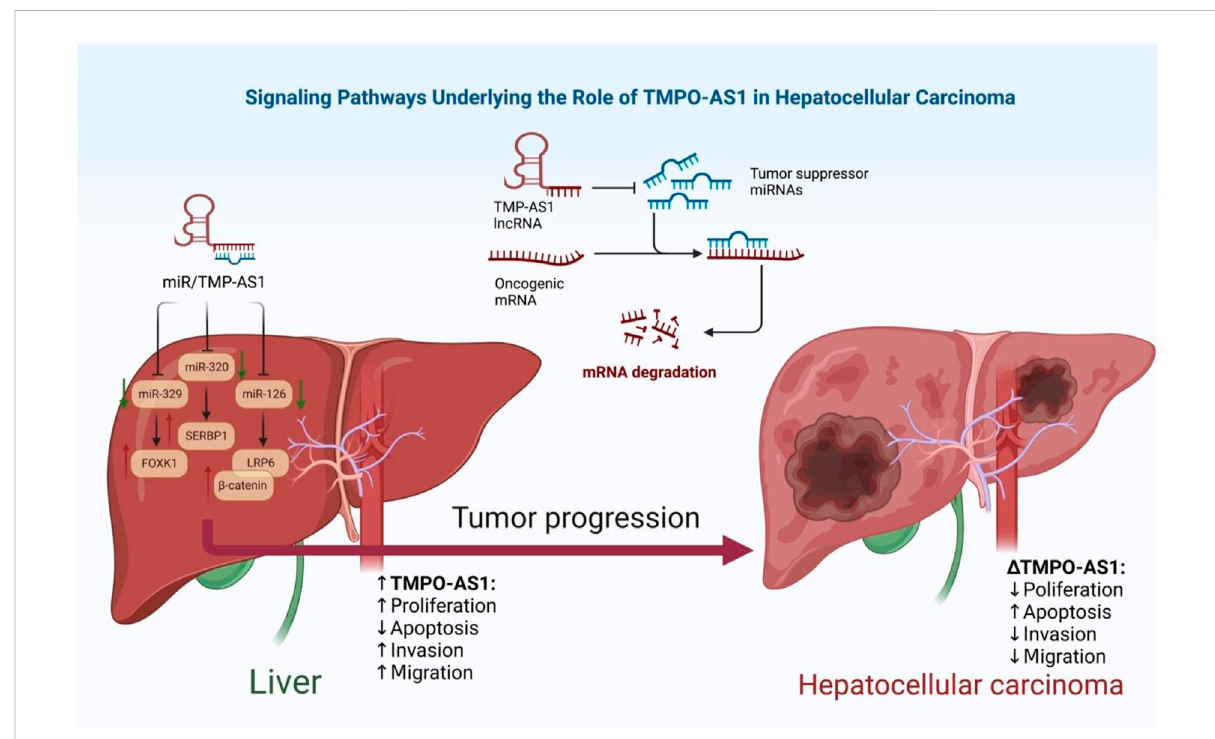
FIGURE 1 Signaling Pathways underlying the role of TMPO-AS1 in Hepatocellular